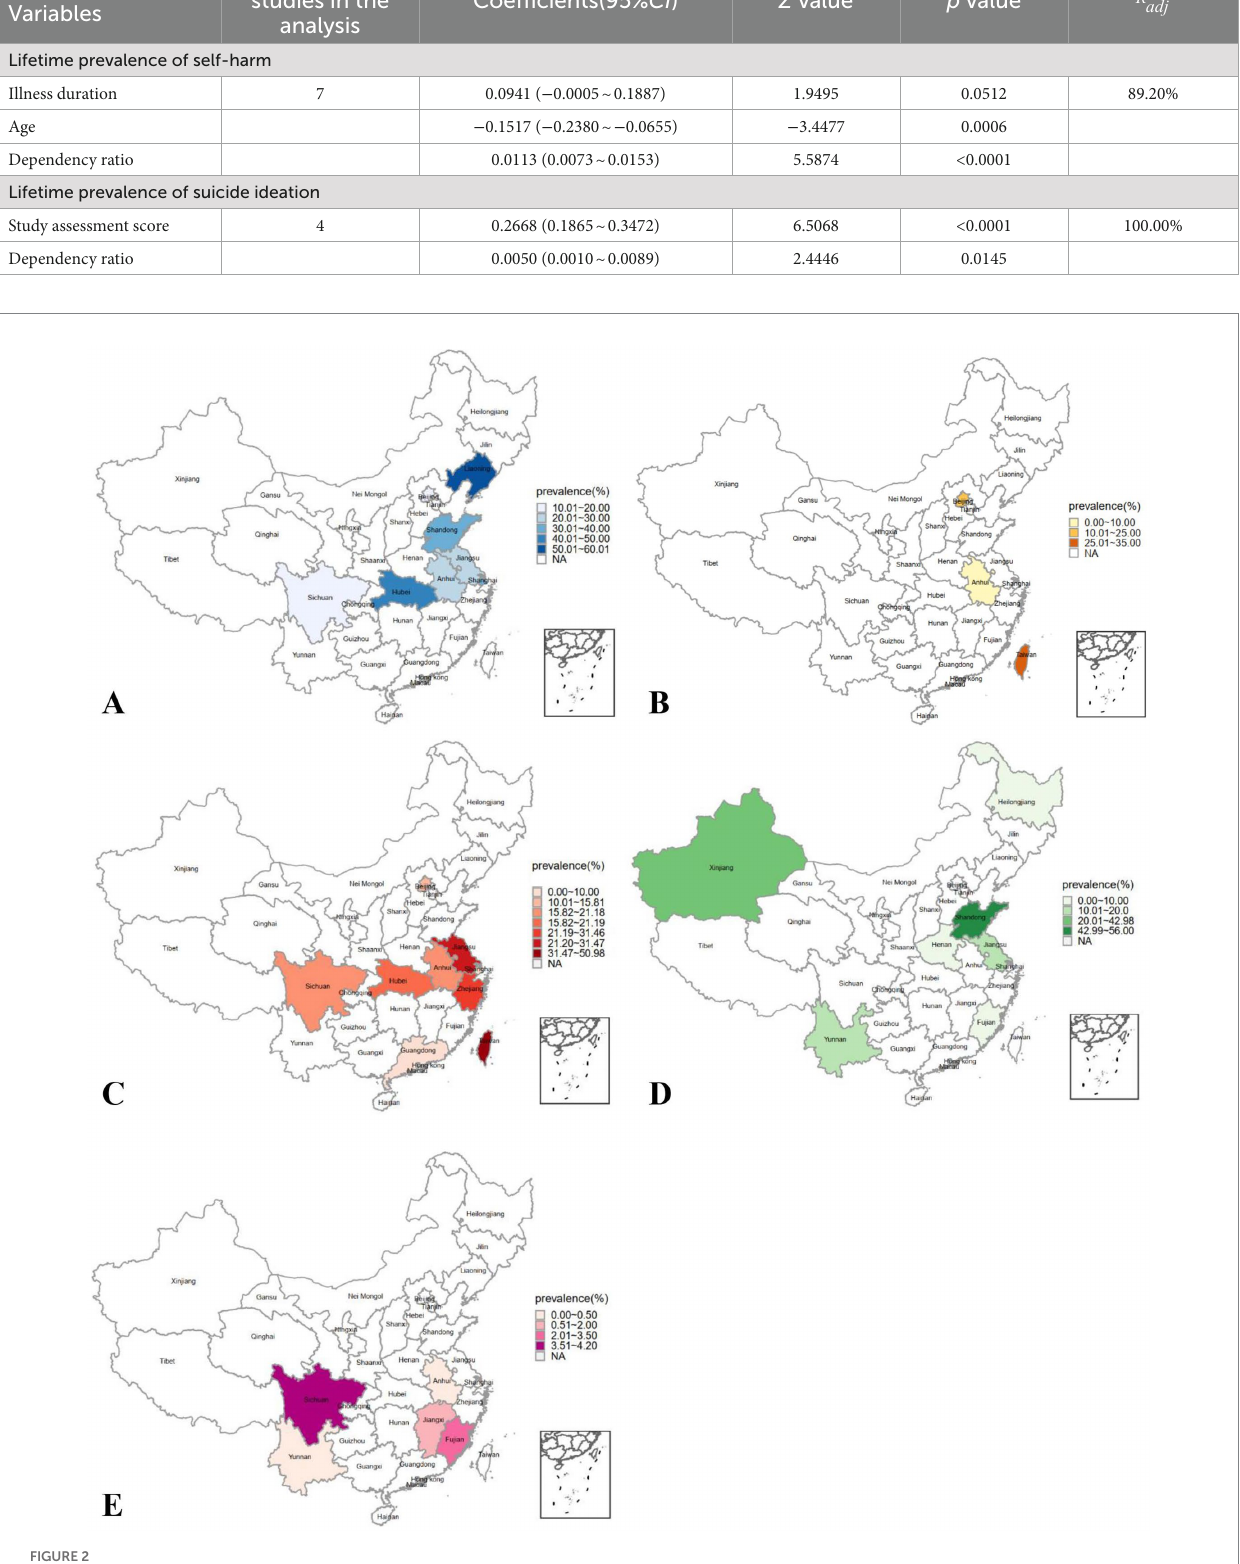
TABLE 3 Multivariate meta-regression models of moderators of lifetime prevalence of self-harm and suicide ideation.